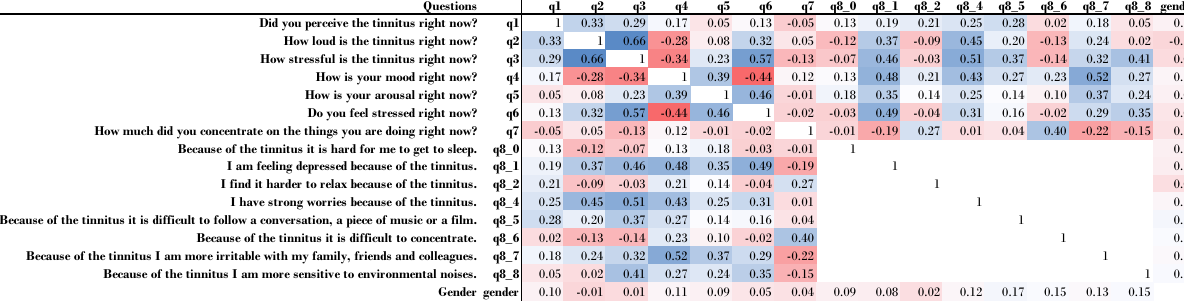
Figure 6. Heatmap for feature-gender cross-correlations. The last column (resp. the last row) shows the correlation of the whole data set (without equal splits for male and female individuals) with the target gender. Depending on the feature scaling, different correlation approaches (Cramer’s V, Pointbiserial and Pearson) have been used. The matrix reveals strong positive correlations between stressfulness and loudness of the tinnitus or negative correlations between mood and stressfulness of an individual user. The heatmap was formatted using MS Excel 365. Correlation metrics were calculated using SciPy 1.5.0 within a Python 3.7